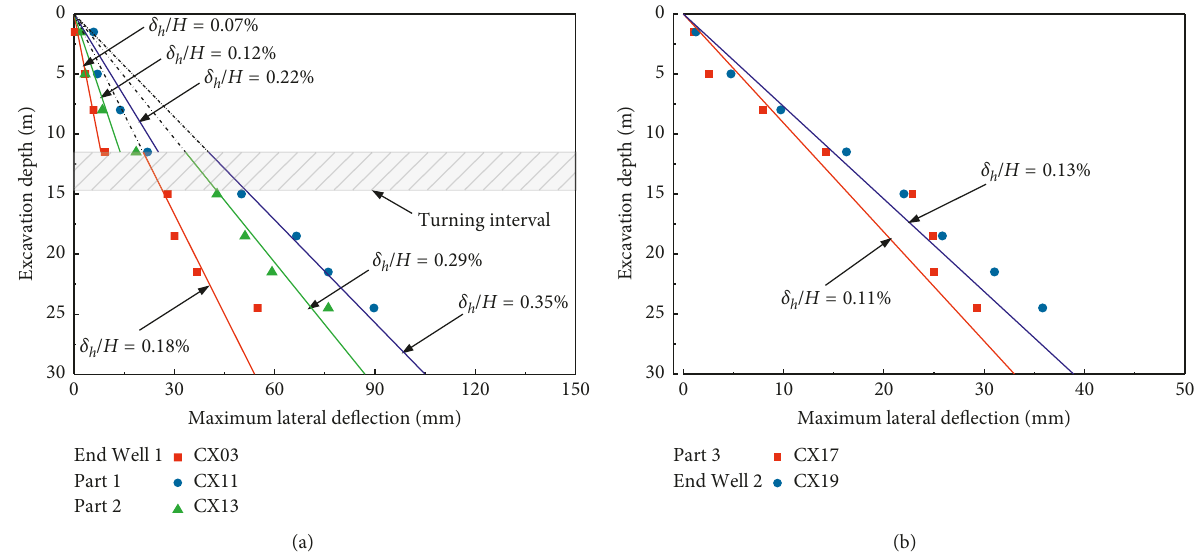
Figure 10: Ratio of the maximum lateral deflection of the diaphragm wall to excavation depth ( δ